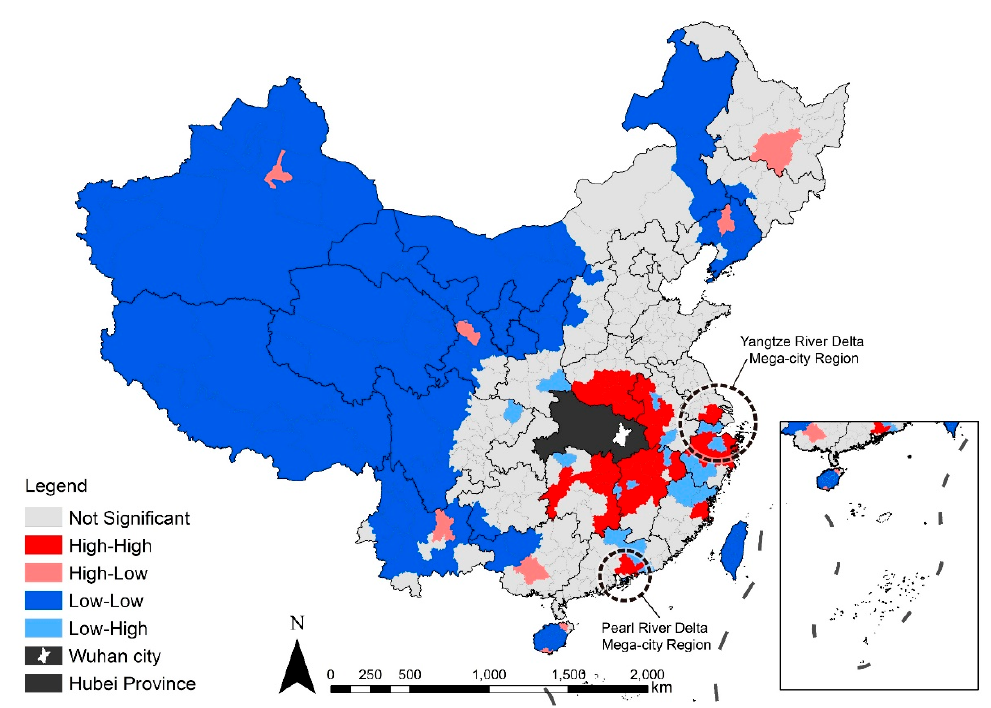
Figure 5. Bivariate local spatial autocorrelation with population outflow from Wuhan and cumulative confirmed COVID-19 cases.